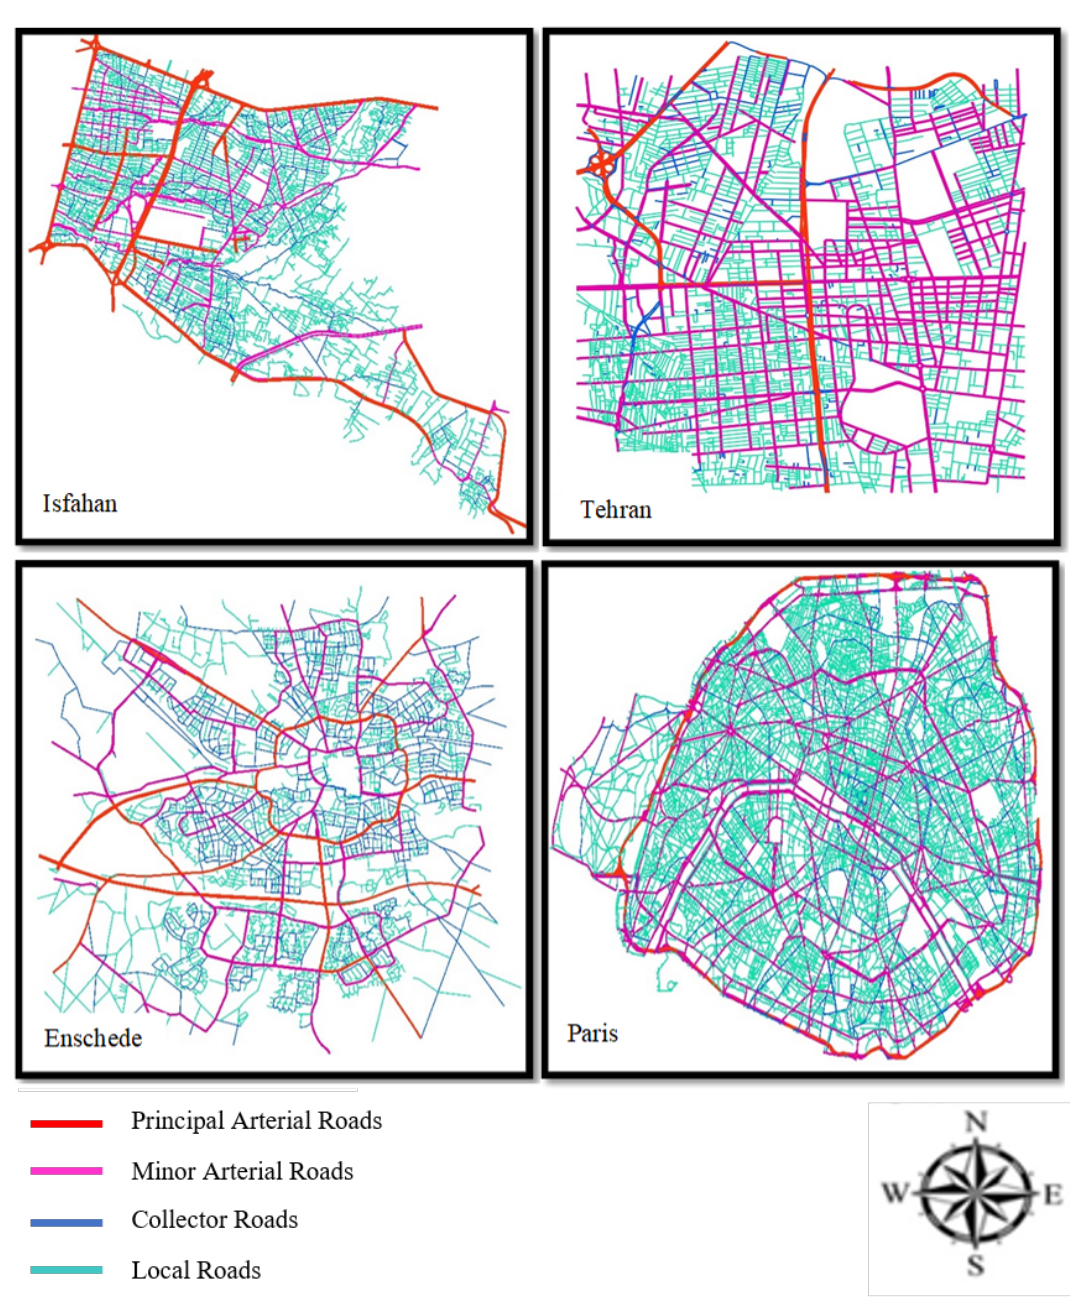
Figure 1. Functional classes of the urban street network in four different